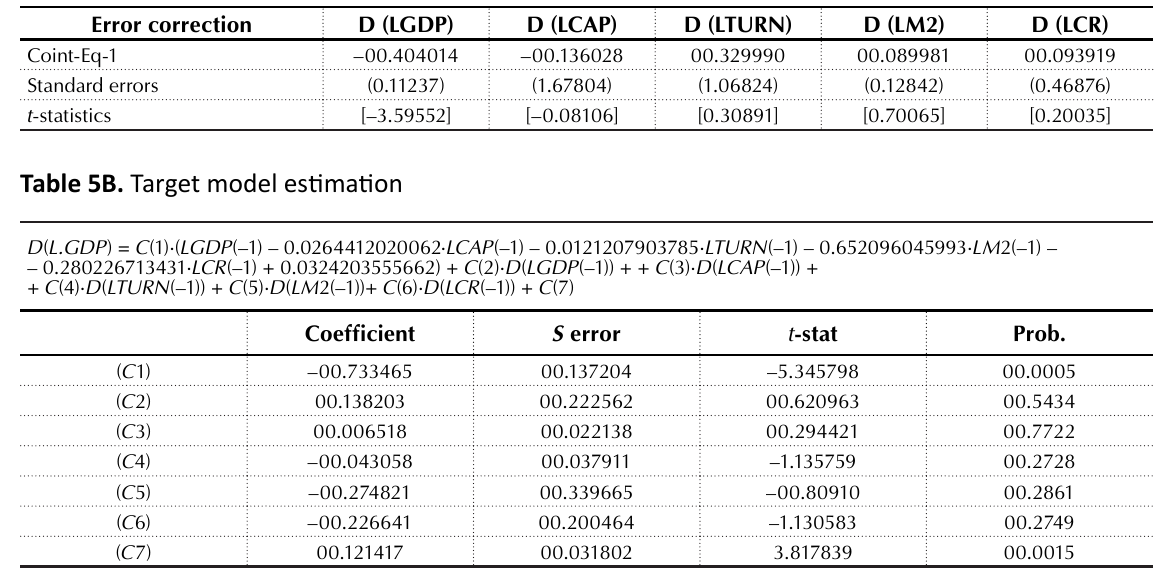
Table 5A. The results of VECM